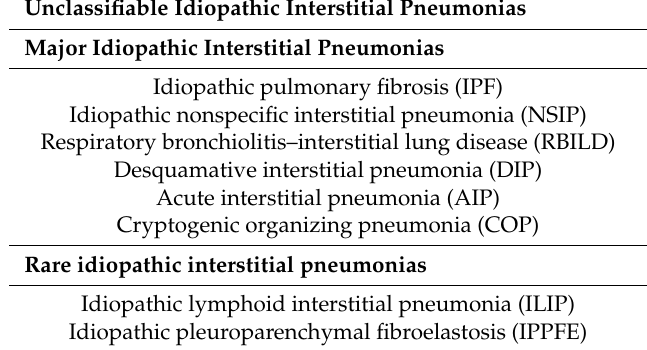
Table 2. Classification of idiopathic interstitial pneumonias. Modified from Travis et al.